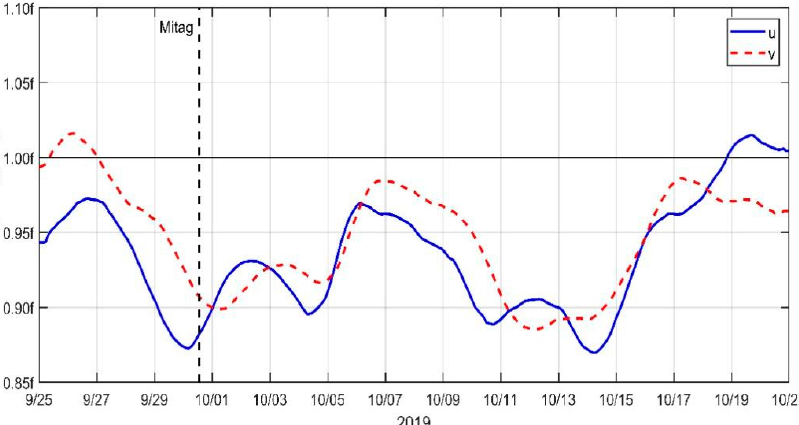
Figure 12. Time evolution of one inertial period low-pass filtered spectral peak frequency of the near-inertial band 0.70 f –1.12 f , and the blue solid and red dashed lines represent the zonal and meridional residual currents. The horizontal black solid line denotes the frequency of 1.00 f , and the vertical black dashed line denotes the time when typhoon Mitag’s center was closest to the mooring.